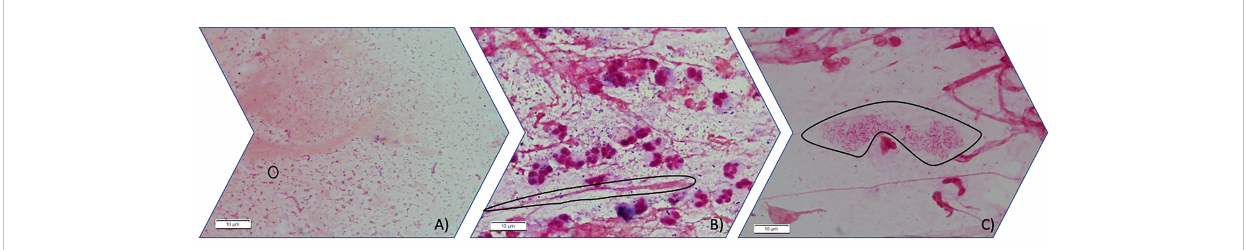
FIGURE 1 Three different stages of PA mode of growth in sputum observed by light microscopy (100X). (A) Planktonic stage in which Gram-negative bacilli are seen free fl oating in planktonic mode of growth (circled an individual gram-negative bacilli). (B) Gram-negative bacilli grow aggregated forming immature bio fi lms. (circled an aggregate of gram-negative bacilli inside mucus) (C) Gram-negative bacilli can be found aggregated embedded in an optically distinguishable alginate extracellular matrix circled in the